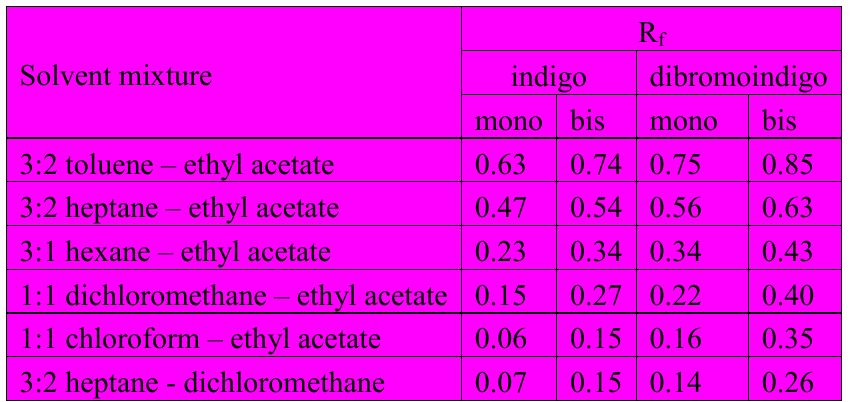
Table 5. R s of N-monotrifluoroacetylindigos f